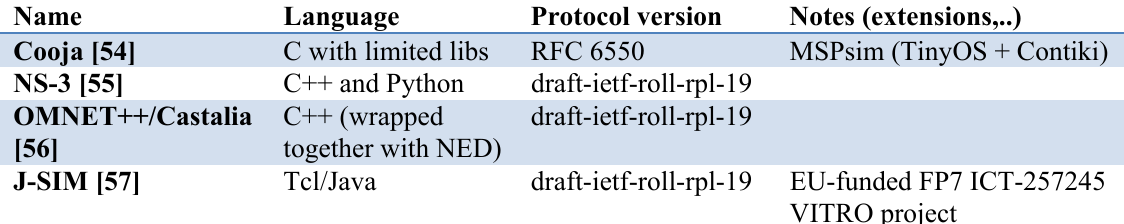
Table 6. Simulators incorporating